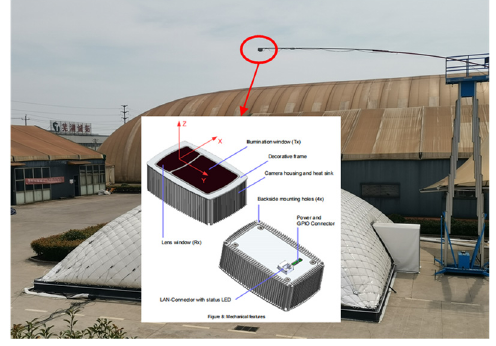
Figure 18. Radar installation